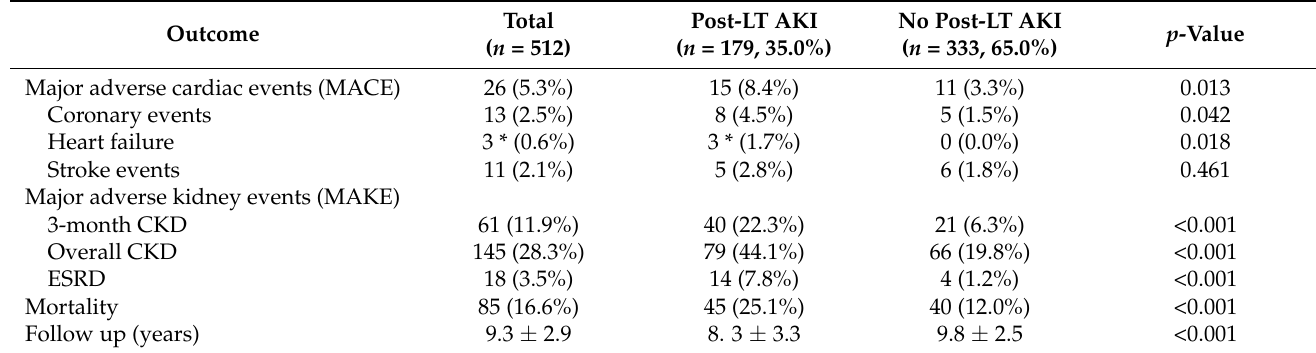
Table 2. Long-term Cardiovascular and Renal Outcomes after Post-LT AKI.